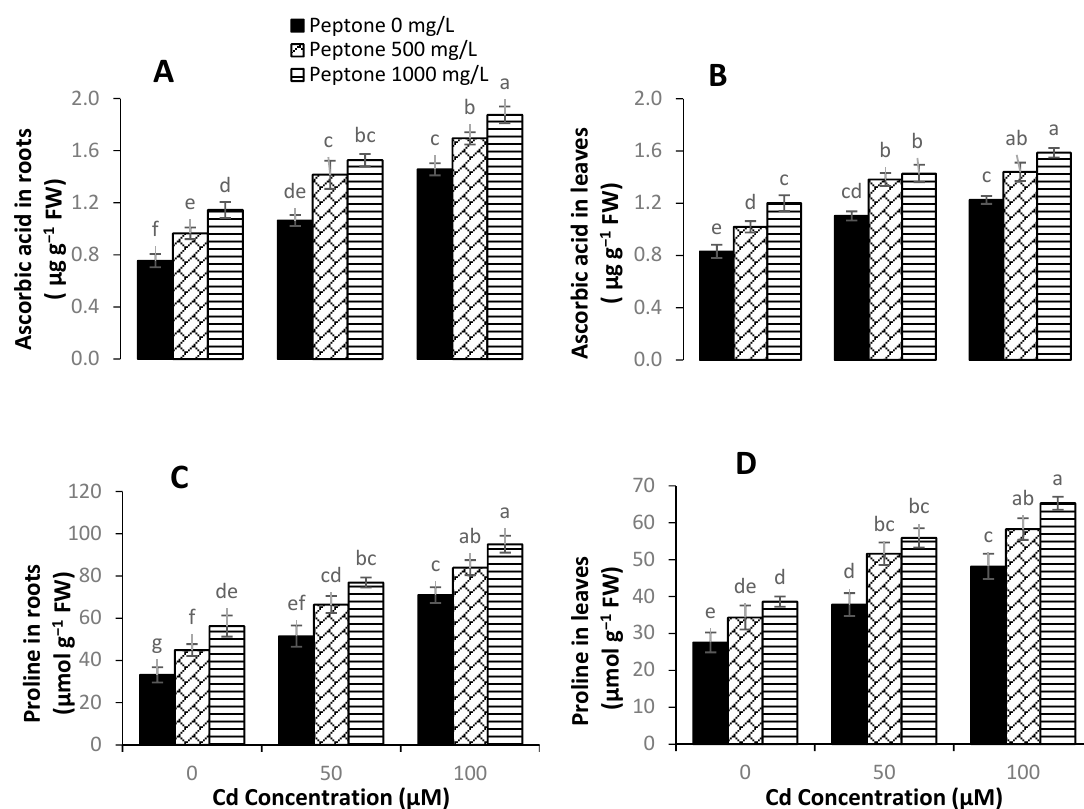
Figure 6. The influence of the foliar application of peptone (0, 500, and 1000 mgL − 1 ) on the levels of ascorbic acid in root ( A ), ascorbic acid in leaves ( B ), proline in roots ( C ), and proline in leaves ( D ) of spinach plants grown under Cd stress. Values represent the means of four replicates with standard deviations. Letters on the bar indicate the significant di ff erences between given treatments at p < 0.05.